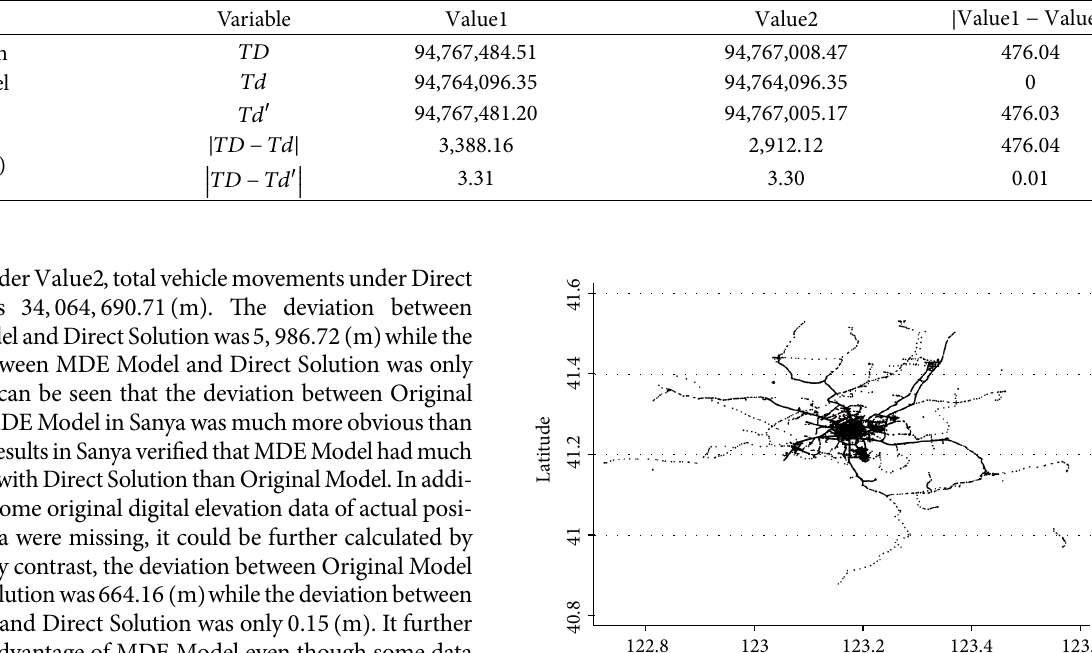
Table 4: Zhengzhou results and comparisons of three methods. Unit: m.